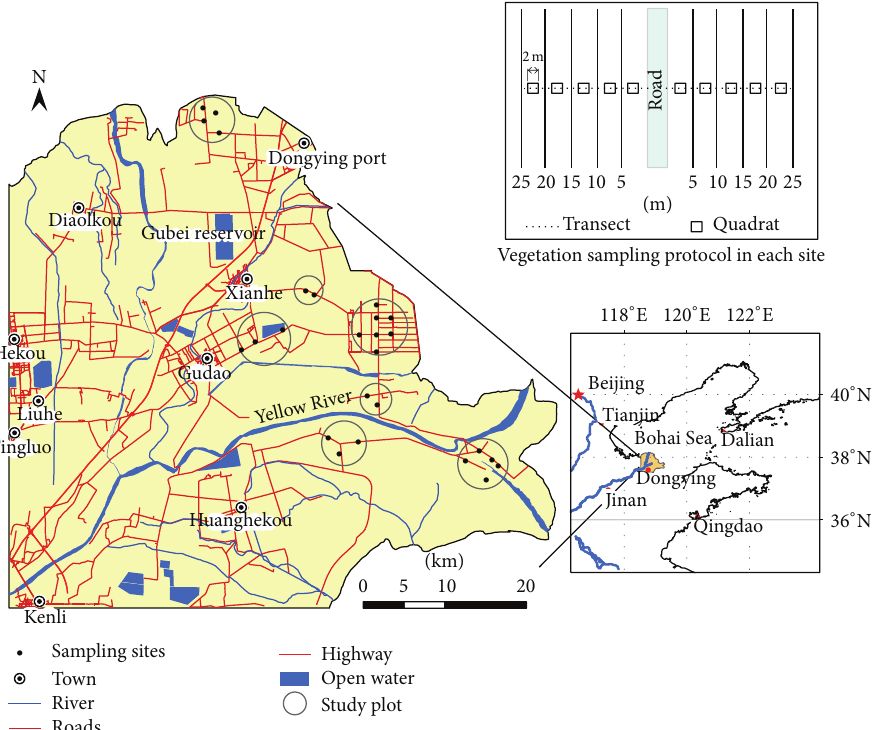
Figure 1: Location of the study area and sampling sites in the Yellow River